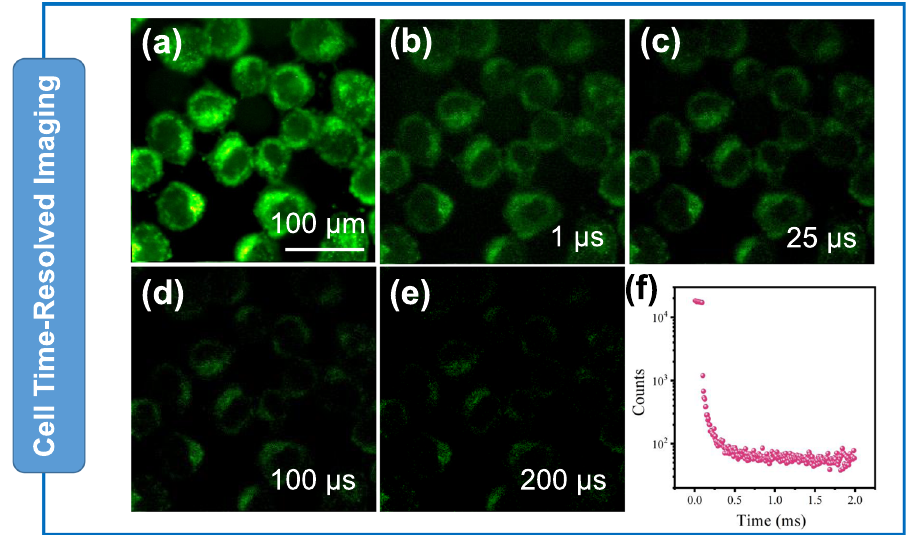
Fig. 5 Time-resolved cellular imaging. a – e Images of HeLa cells at different delay times. f Lifetime decay pro fi le of the emission band in HeLa cells. HeLa cells were incubated with TPM (10 μ M) at 37 °C for 10 min. The excitation wavelength was 405 nm. Each experiment was repeated three times